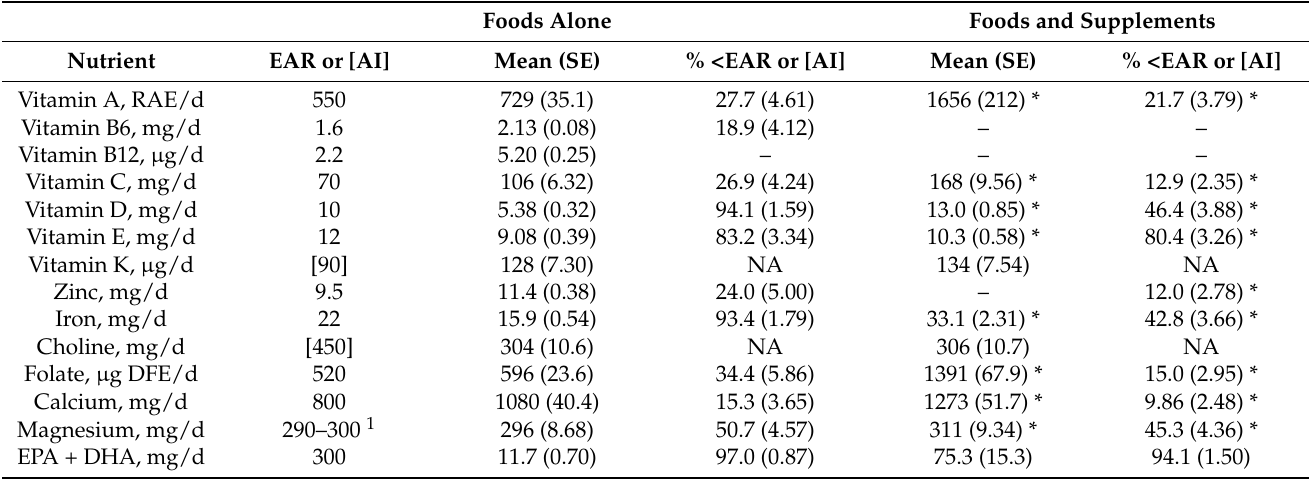
Table 3. Total usual intakes of nutrients important for neurodevelopment among pregnant